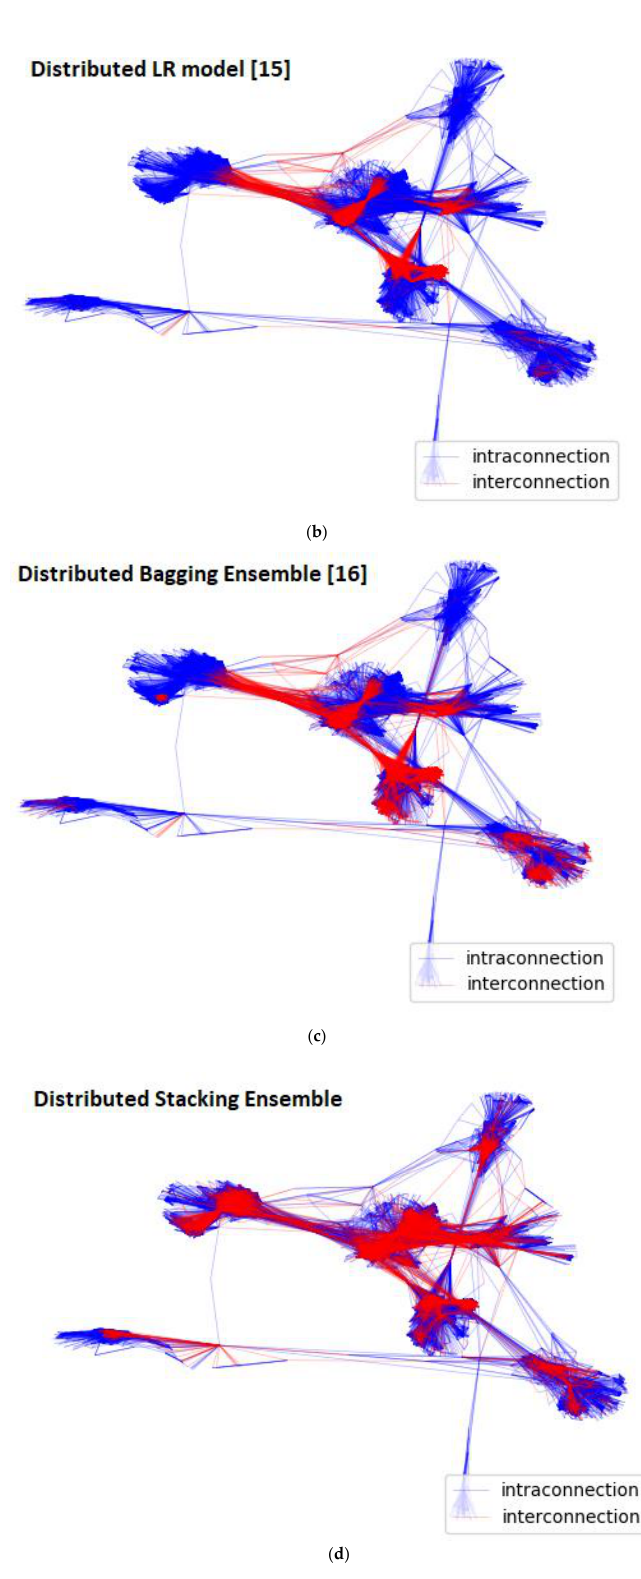
Figure 3. Extracted Community Structure per different community prediction methodology for Facebook [20] graph: ( a ) Louvain algorithm’s [7]; ( b ) Distributed LR model [15] methodology’s returned; ( c ) Distributed bagging ensemble [16] methodology’s; ( d ) Distributed stacking ensemble methodology’s.